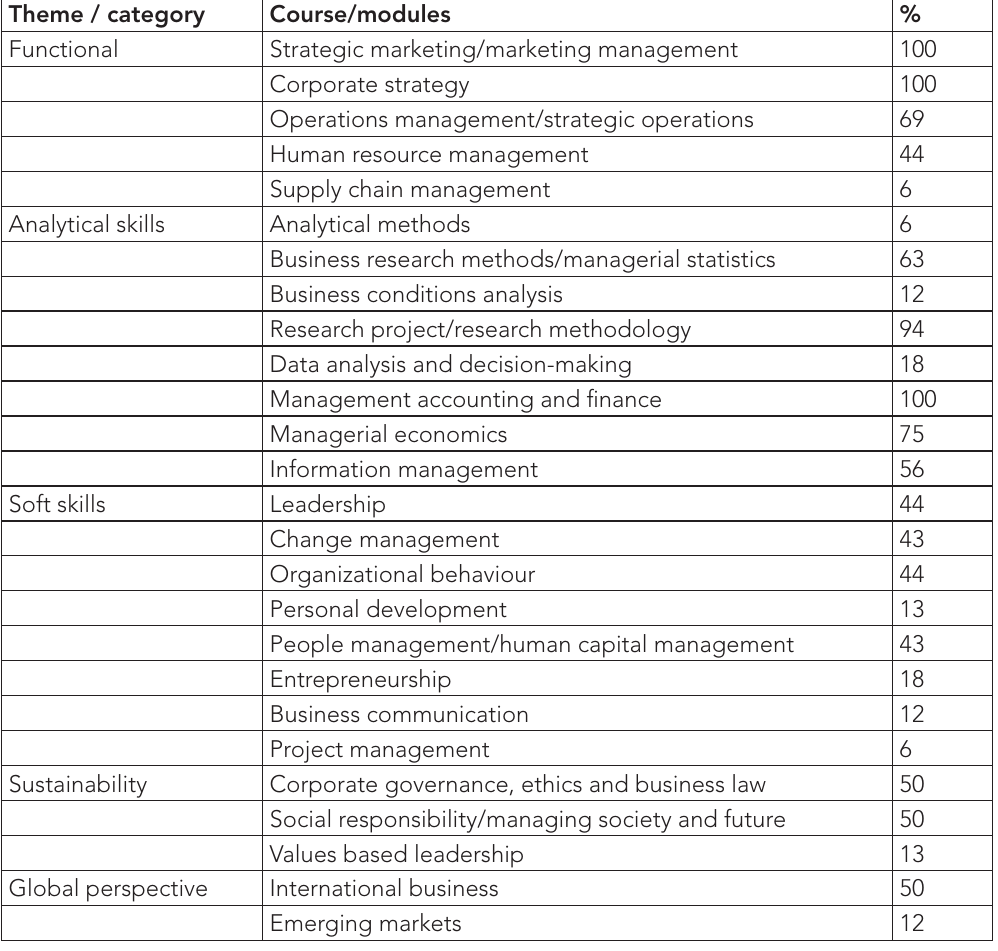
Table 7: MBA core curriculum of South African Business Schools Theme /